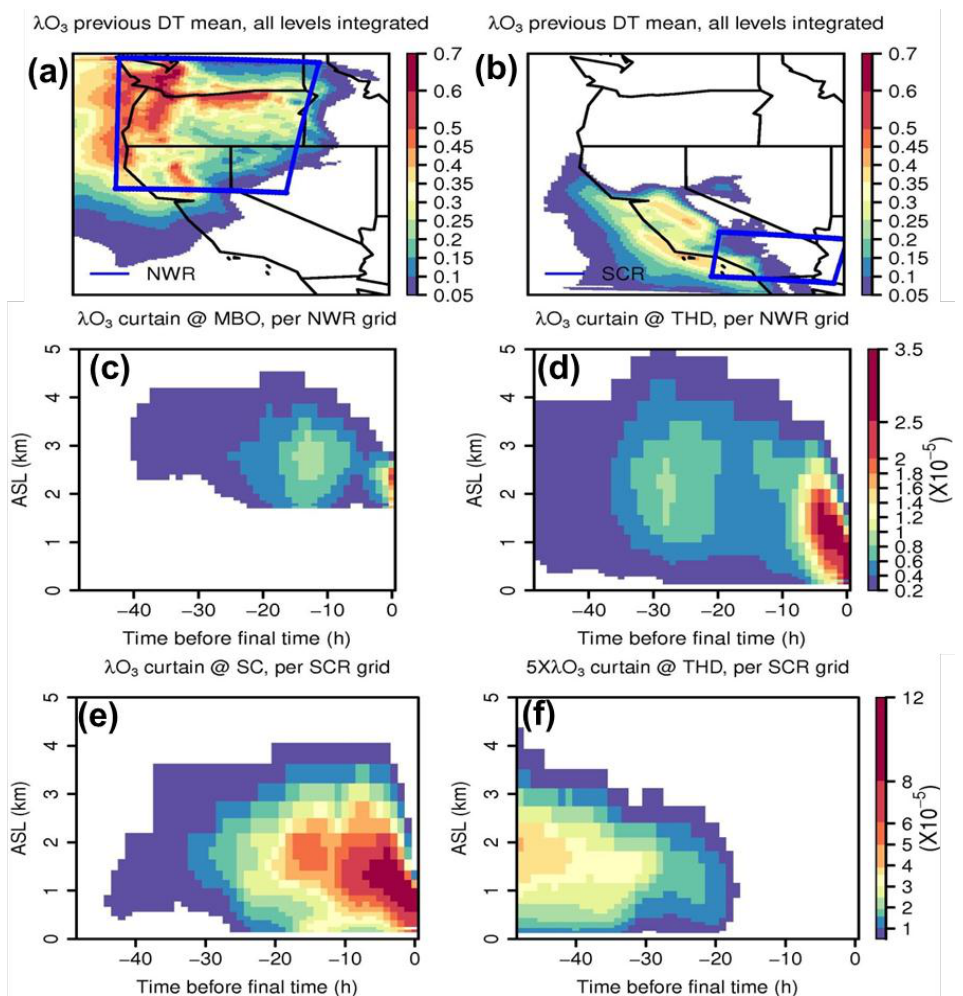
Fig. 9. Previous daytime-mean O 3 adjoint sensitivities ( λ [O 3 ]) in (a) NWR case and (b) SCR case, all levels integrated. Areas within the blue lines indicate the receptor regions. (c) λ [O 3 ] time-height curtain at MBO, NWR case; (d) λ [O 3 ] time-height curtain at THD, NWR case; (e) λ [O 3 ] time-height curtain at SC, SCR case; (f) λ [O 3 ] time-height curtain at THD, SCR case. (c–e) were normalized by receptor grid numbers, note the different color scales for NWR and SCR